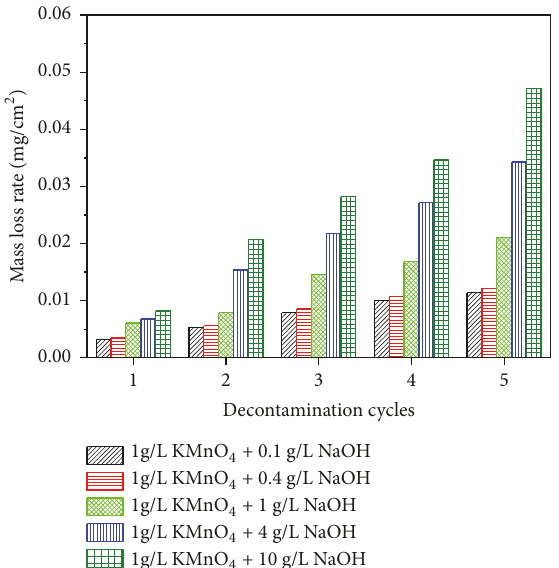
Figure 2: The mass loss of 304L SS carrying out AP-N decontami- nation.